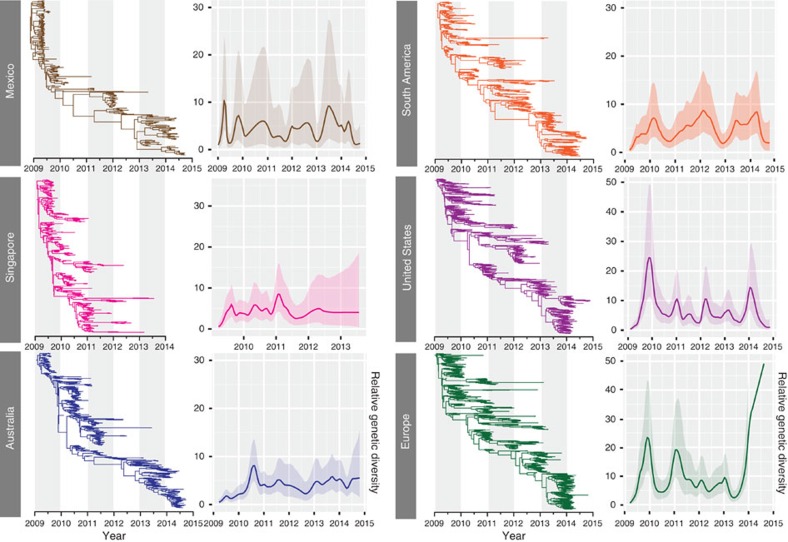
Comparative phylogenetic analyses and population dynamics of H1-HA viruses circulating in different geographical regions, 2009–2014.Phylogenies were inferred using the uncorrelated lognormal relaxed clock model and relative genetic diversity estimated using the Gaussian Markov Random Field (GMRF) model. Solid lines in the GMRF plot represent the mean relative genetic diversity through time, while the corresponding shaded areas indicate the 95% HPD intervals.